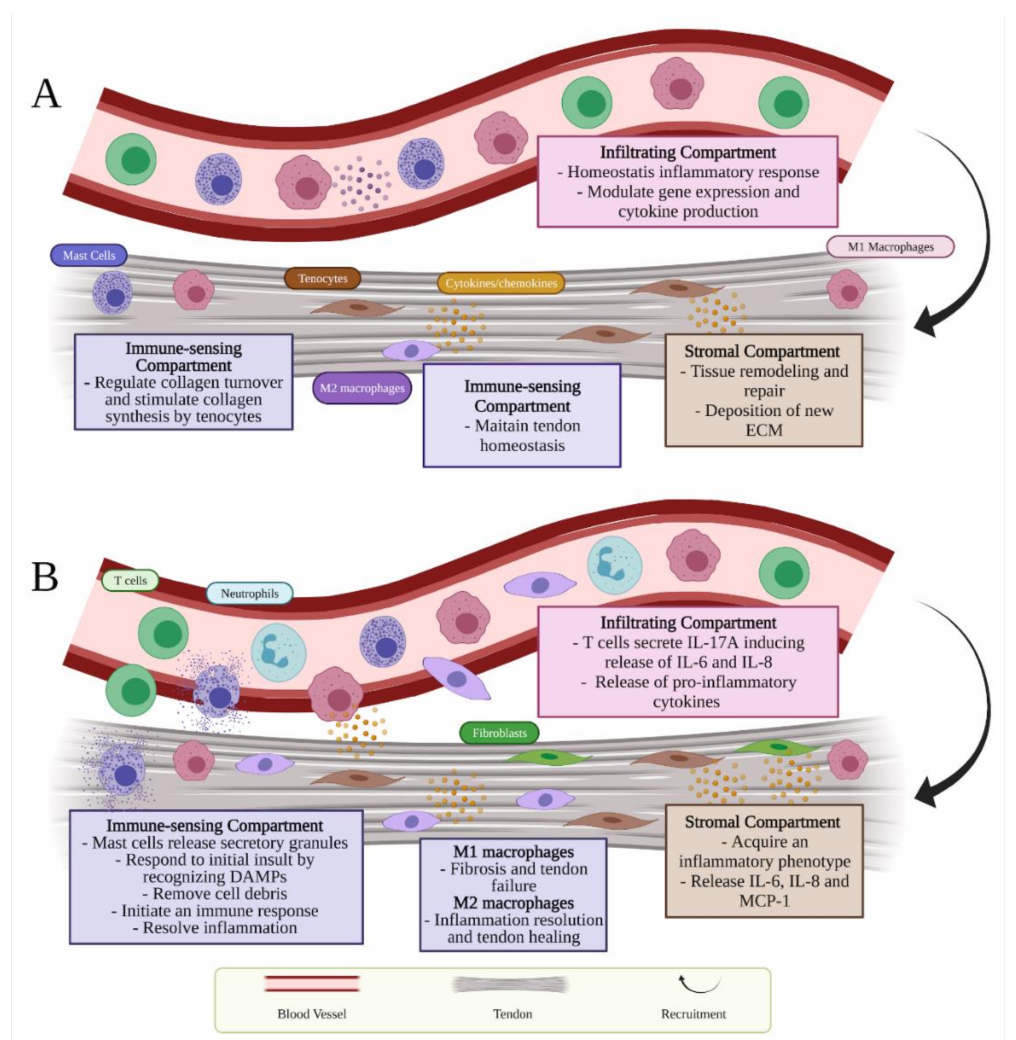
Figure 1. Schematic presentation of tendon immunobiology which describes the different role of cell compartments during ( A ) homeostasis and ( B )